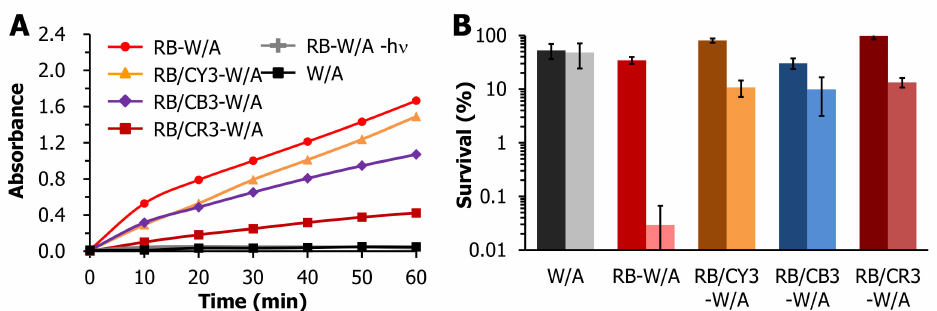
Figure 2. ( A ) The absorbance of I 3 − (352 nm) in the 0.5 M KI solution that underwent photooxidation by RB-W / A (red), RB / CY3-W / A (orange), RB / CB3-W / A (purple), and RB / CR3-W / A (maroon) in comparison with a photosensitizer (PS)-free light control (black) and RB-W / A dark control (grey) as a function of illumination time (0–60 min). ( B ) Photodynamic antibacterial studies against Staphylococcus aureus using RB / CY3-W / A, RB / CY3-W / A and CY3-W / A. Displayed is the % survival for each sample in